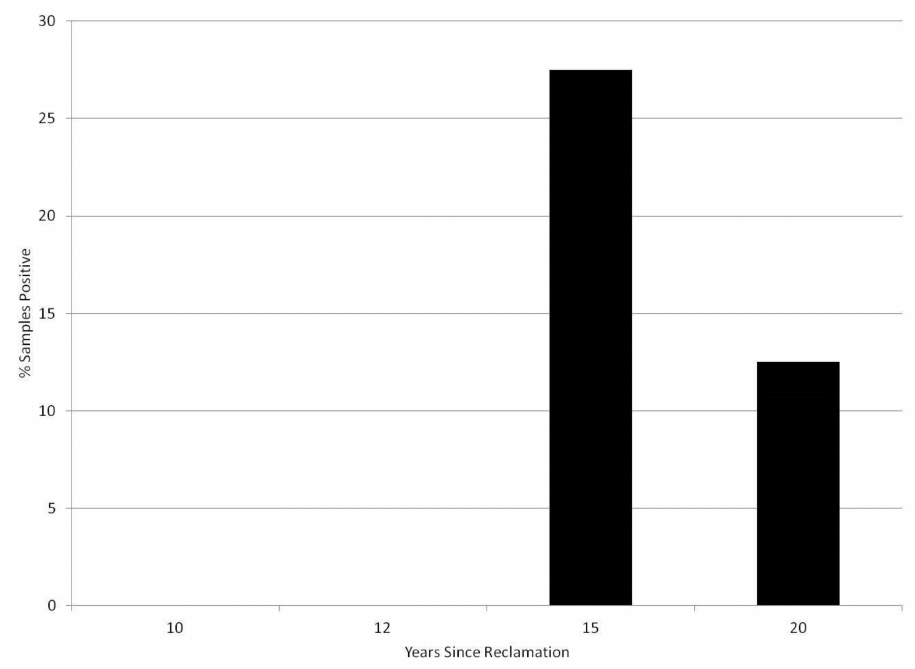
Figure 9. Incidence of Phytophthora cinnamomi in mine soils over time since